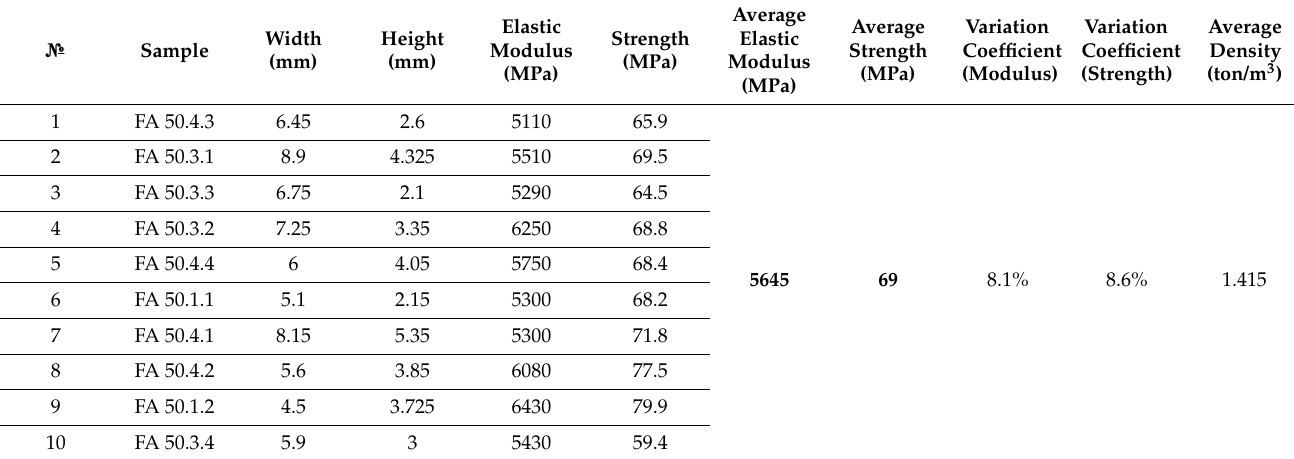
Table A28. Three-point bending test results at 23 ◦ C of filled binder (EP-FA50).